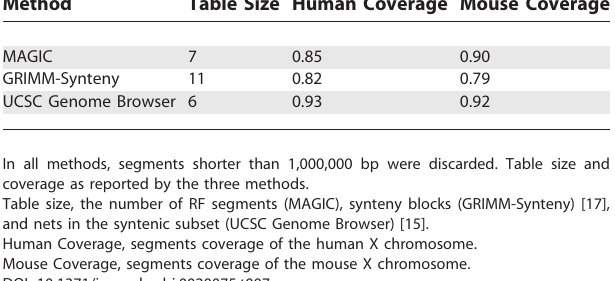
Table 7. Comparing the Results of MAGIC, GRIMM-Synteny, and the UCSC Genome Browser on Human–Mouse X Chromosome Method